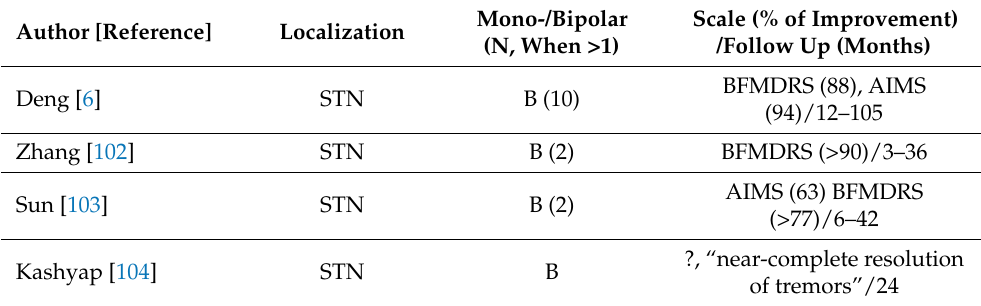
Table 5. Basic parameters and outcomes from STN DBS studies.